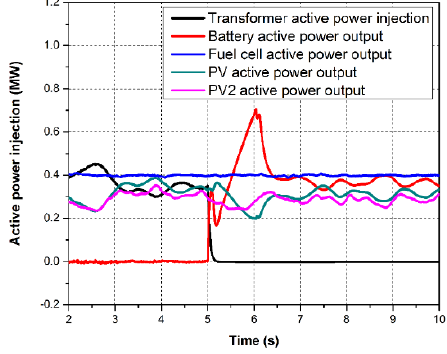
Figure 14. Simulation results of the microgrid.